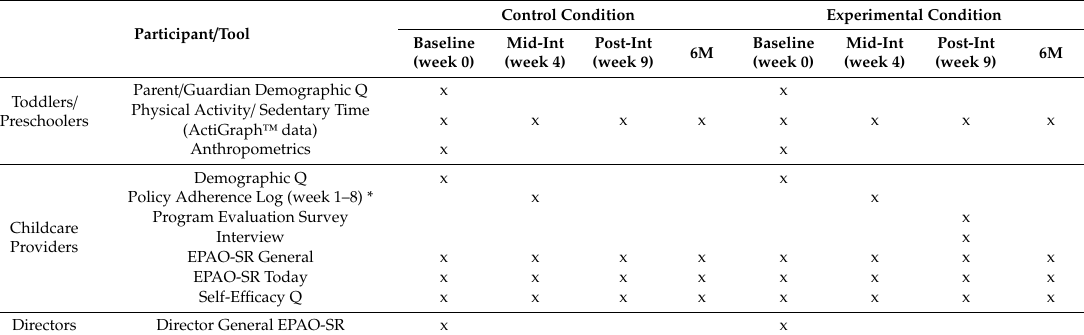
Table 2. Outcome assessments for the Childcare PLAY Policy